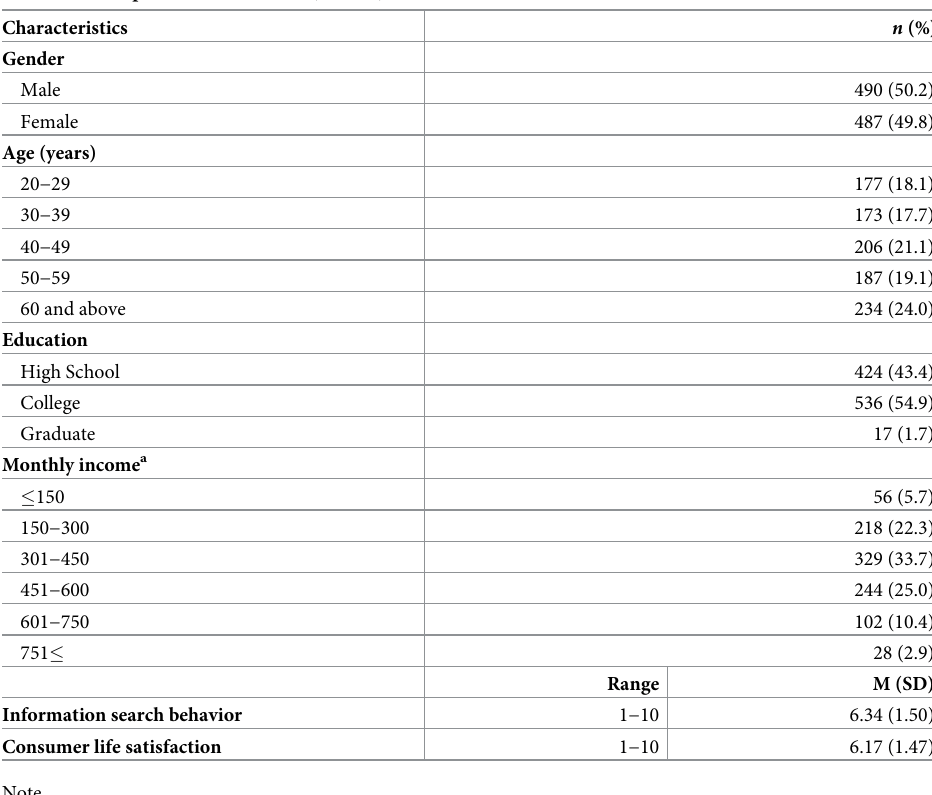
Table 1. Participants’ characteristics (n =